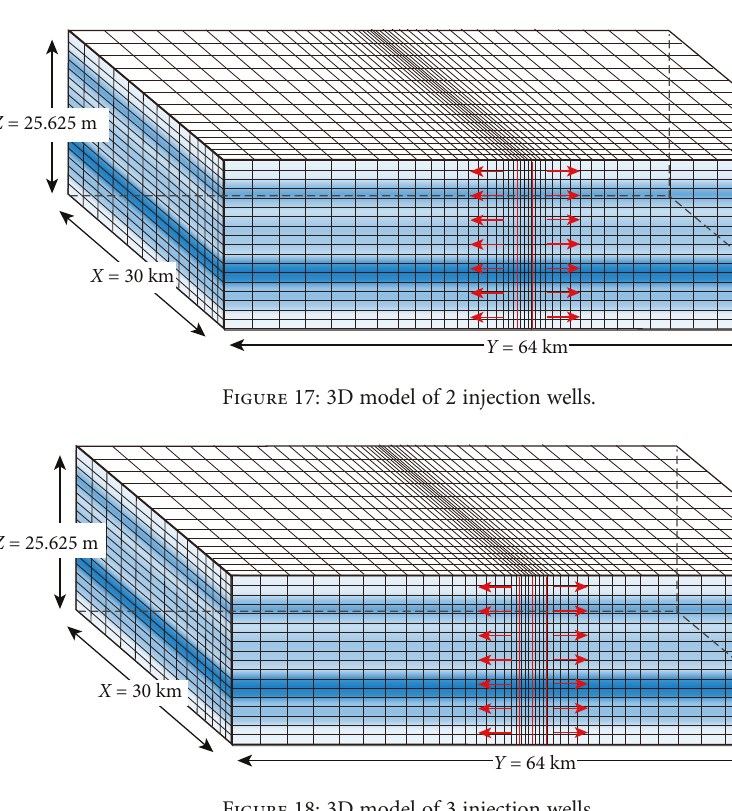
Figure 18: 3D model of 3 injection wells.